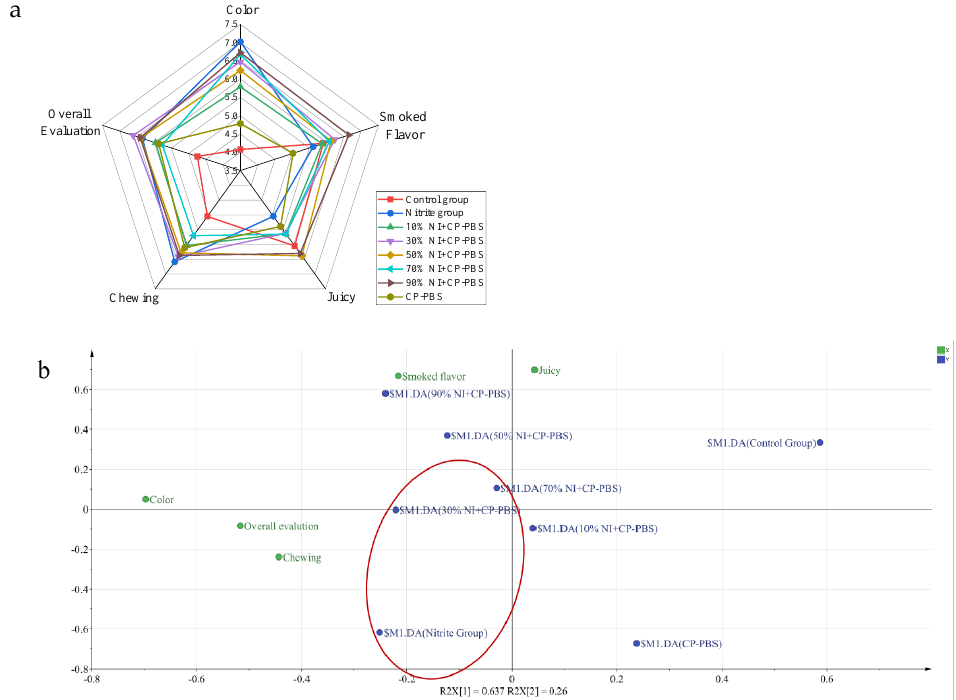
Figure 7. Radar ( a ) displaying the sensory scores of the smoked sausages, color, smoked flavor, juiciness, chewiness, overall evaluation, and PLS − DA bioplot ( b ) analysis of the sensory assessment of the smoked sausage in the different treatment groups.